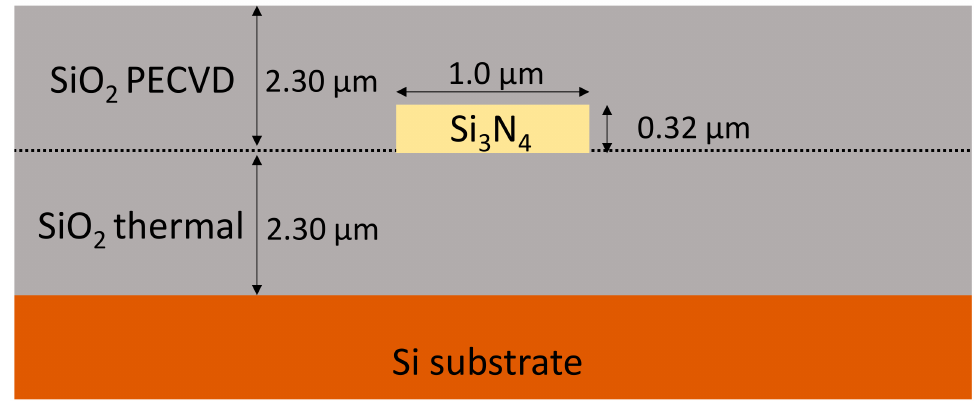
Figure 1. A cross-section of Si 3 N 4